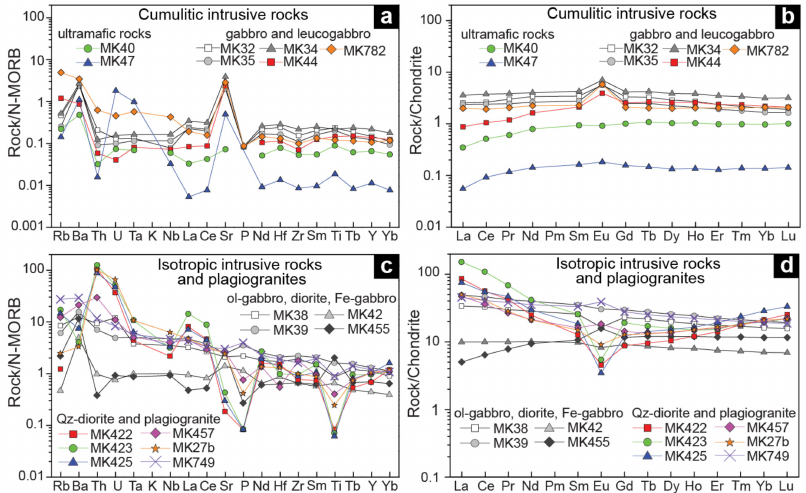
Figure 7. N-MORB (normal-type mid-ocean ridge basalt)-normalized incompatible element patterns ( a , c ) and chondrite-normalized rare earth element (REE) patterns ( b , d ) for mafic and ultramafic cumulates, isotropic mafic rocks, quartz-diorites, and plagiogranites from the intrusive complex of the Band-e-Zeyarat ophiolite. Normalizing values are from Sun and McDonough